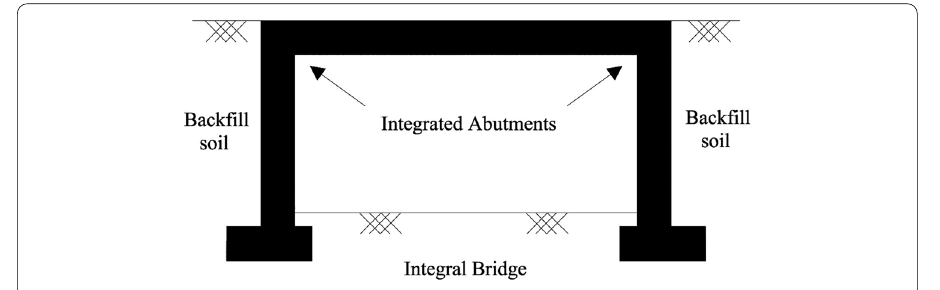
Fig. 1 Schematics view of integral